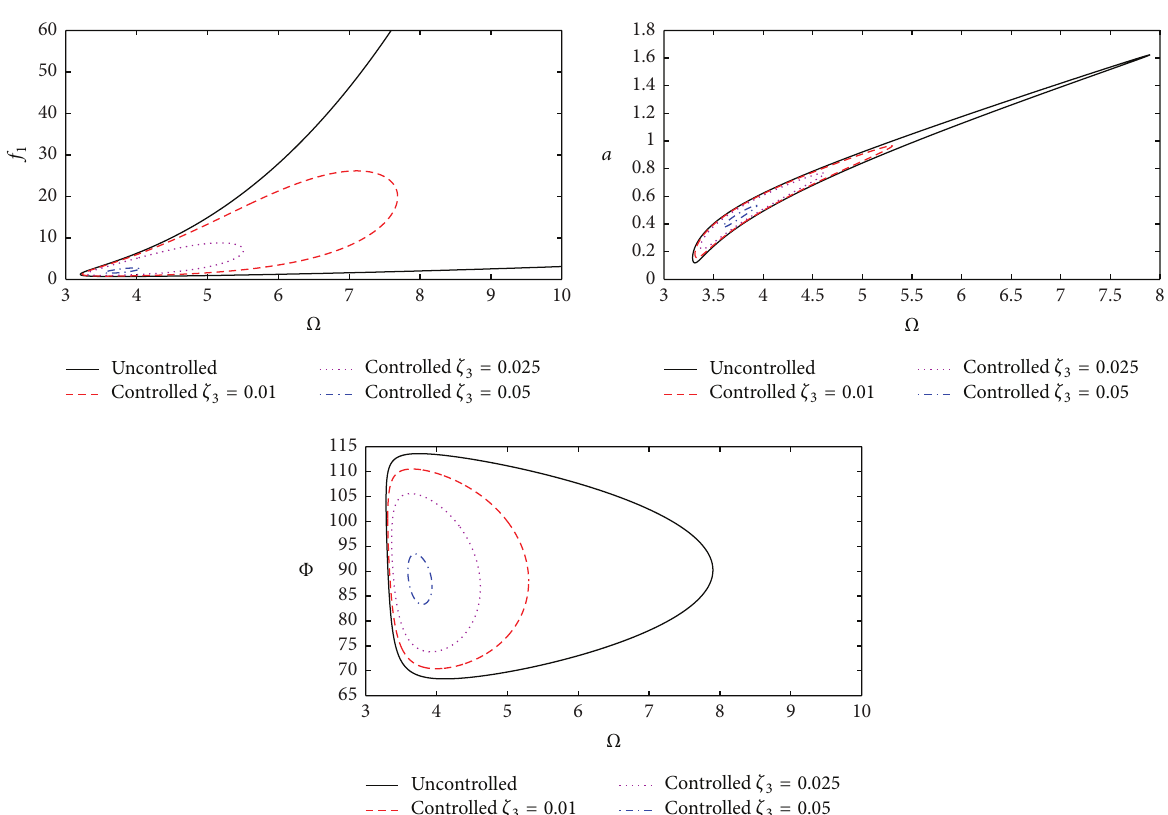
̂𝜆 = 0.4 , and 𝑓 1 = 2 ).